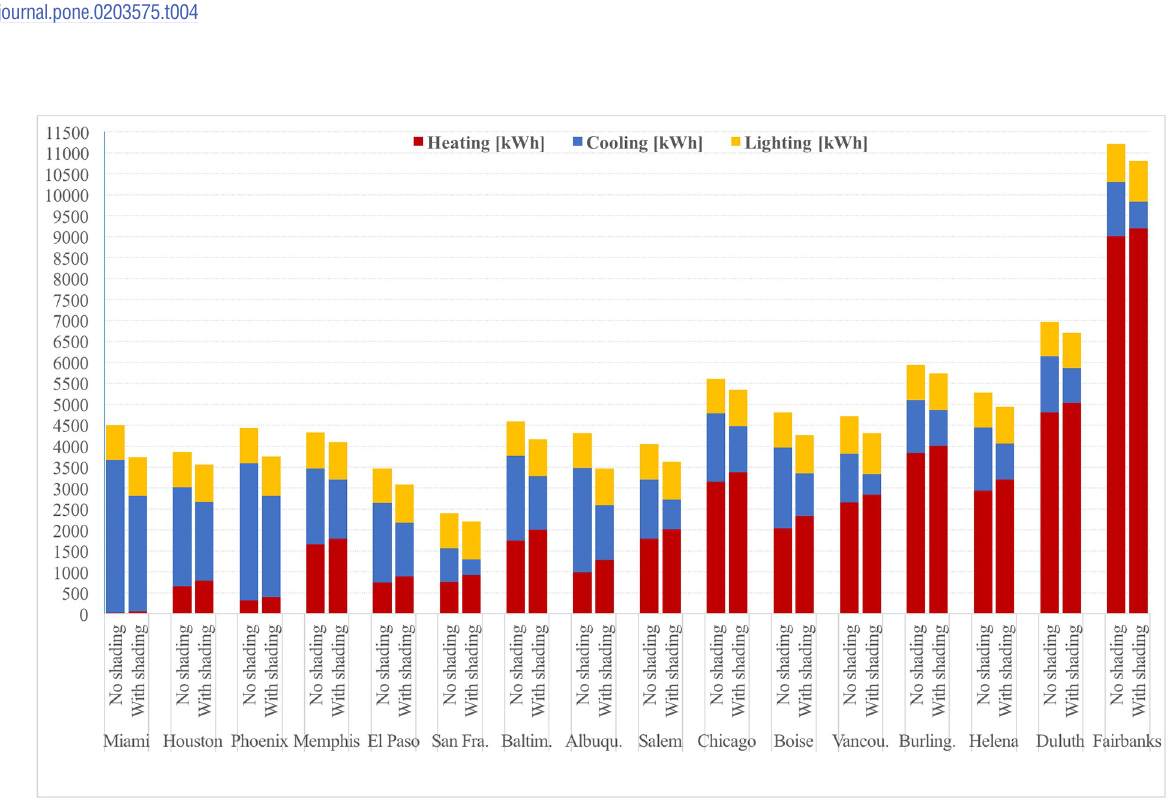
Fig 3. Heating, cooling and lighting loads in models without shading and with optimal